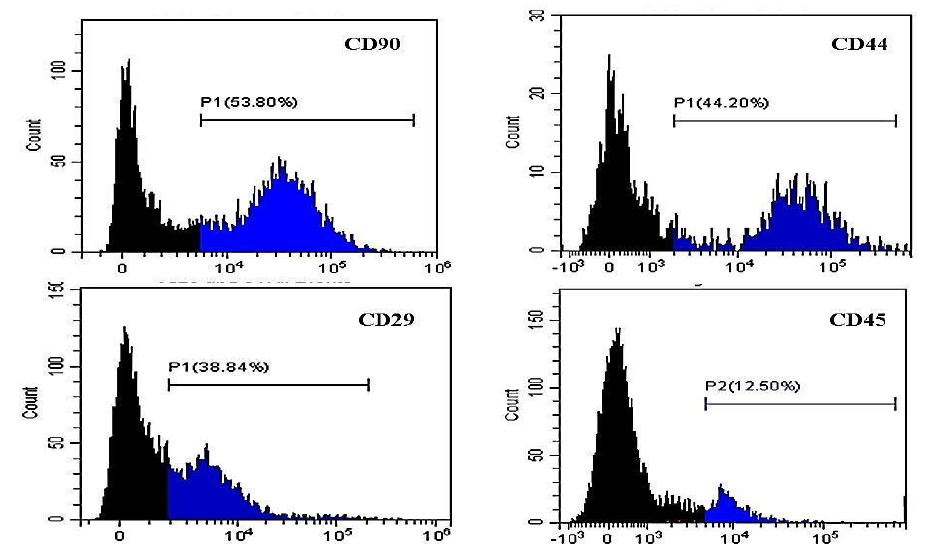
Figure 5. Results of flow cytometry assay of canine SVF cells isolated from the peri-ovarian AT stained with PE-conjugated anti-CD90, anti-CD44, anti-CD29, and FITC-conjugated anti-CD45. Black areas indicate unstained cells. The percentage represents gated positive areas.